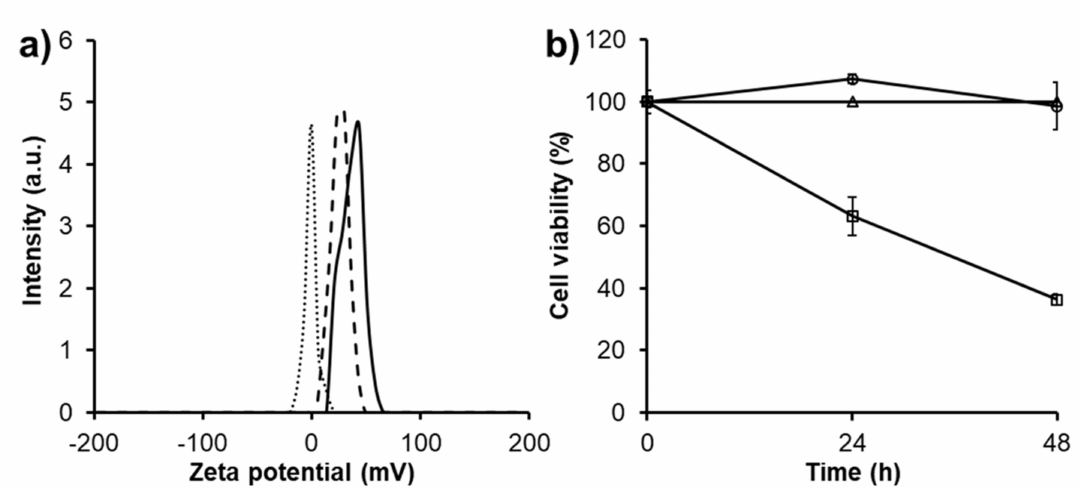
Figure 5. ( a ) Zeta potential showing the surface charge of PAMAM G3.0 (solid curve), PAMAM G3.0@mPEG (dashed curve), and CAR / PAMAM G3.0@mPEG (square dotted curve), ( b ) Viability of L929 mouse fibroblast cells after 48 h cultured with media (triangle), media containing PAMAM G3.0 (500 µ g / mL) (square), and media containing PAMAM G3.0@mPEG (500 µ g / mL)